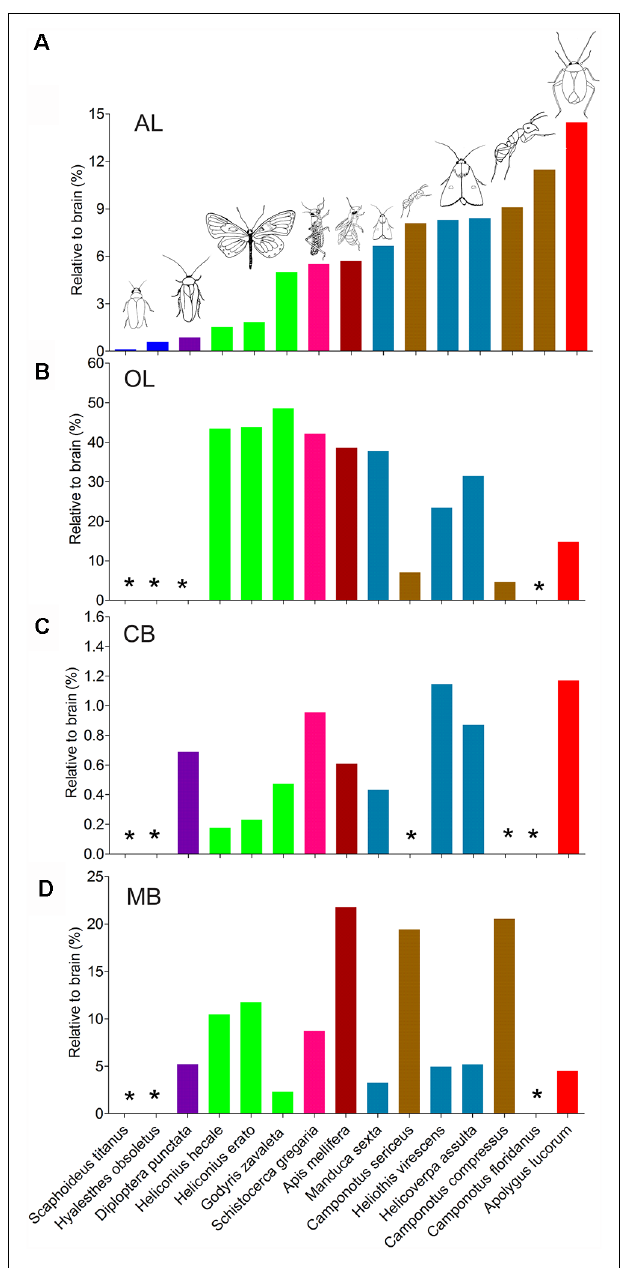
FIGURE 7 | Comparison of relative sizes of the antennal lobe, optic lobe, CB, and mushroom body to the whole brain in different species. (A) Antennal lobe. (B) Optic lobe including medulla and lobula complex. (C) CB. (D) Mushroom body. AL, antennal lobe; CB, central body; MB, mushroom body; OL, optic lobe. *Data missing.